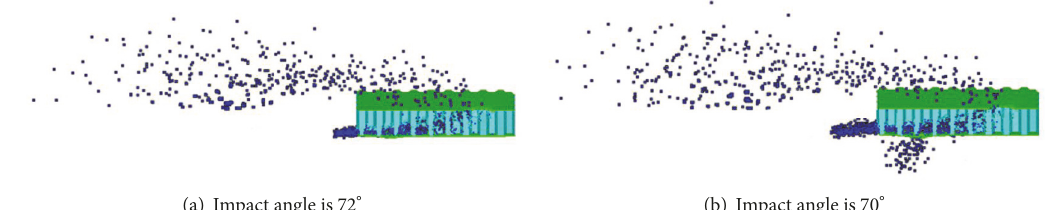
Figure 9: Critical penetration of the rear face